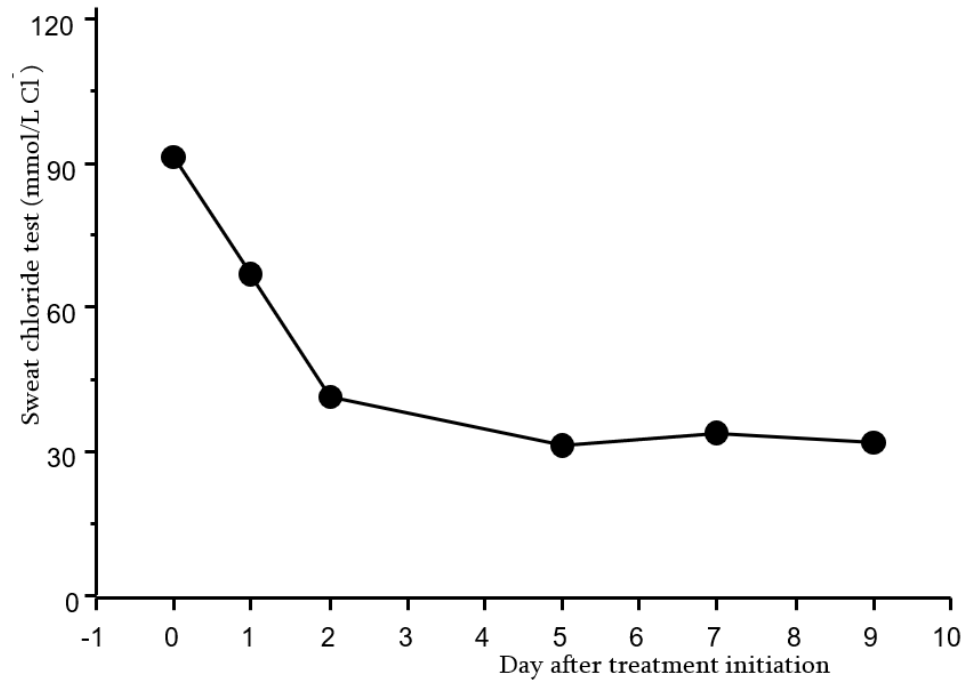
Figure 1. Variation of the sweat chloride concentration after Kaftrio ® in a F508del homozygous patient.